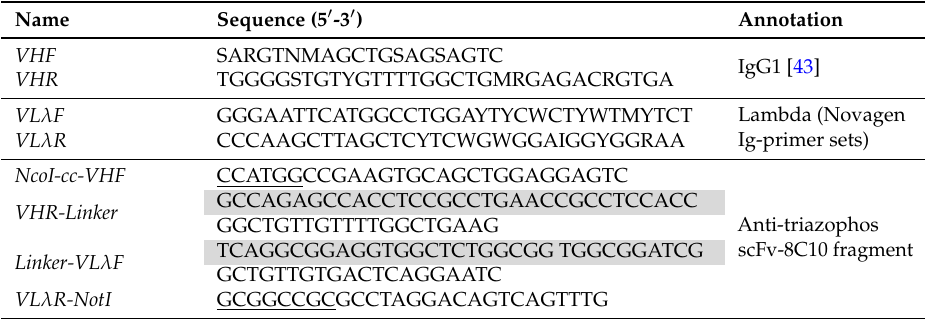
Table 3. Primer sequences for the variable fragments and the full-length anti-triazophos scFv-8C10 gene